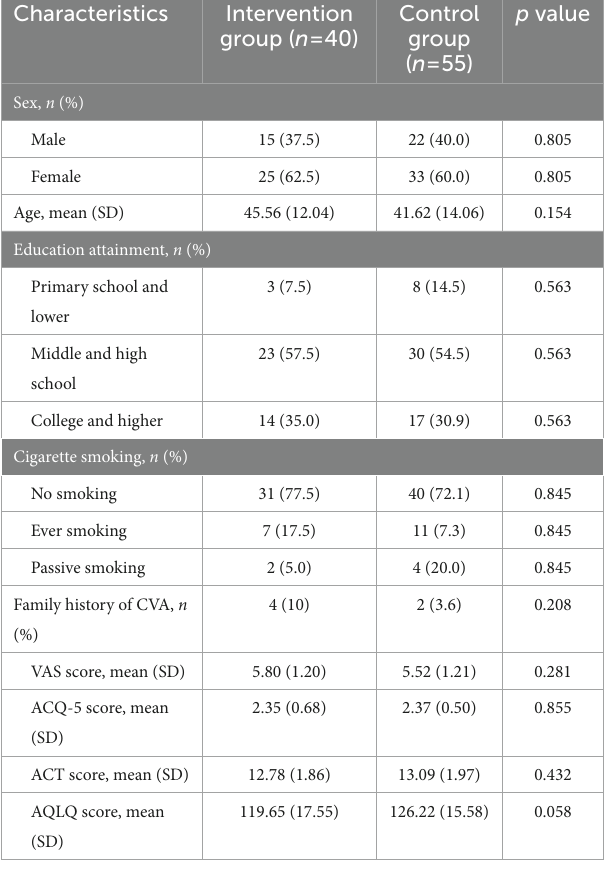
TABLE 1 Demographic characteristics of participants.